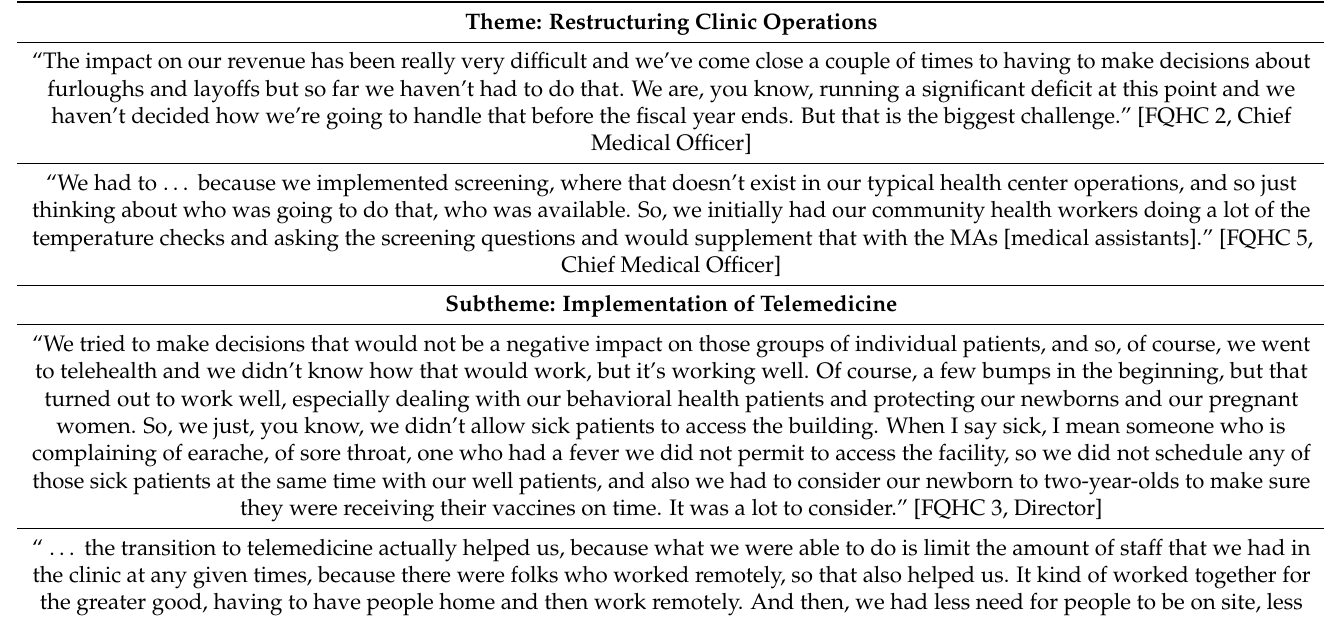
Table 1. Themes and sample quotes from healthcare